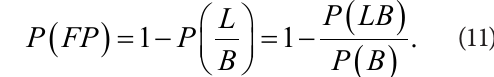
Table 3. Matrix of the pairwise comparison of the qualitative assessment results for the probabilistic level of the financial potential and the bankruptcy procedure commencement probability